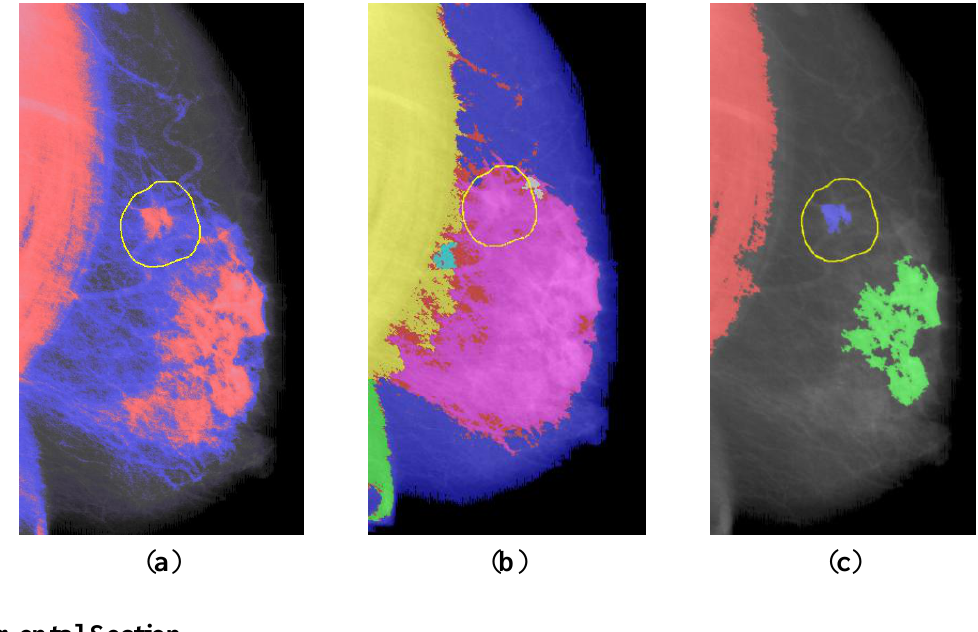
Figure 6. Clustering a mammogram with high tissue density. ( a ) Fuzzy 5-means